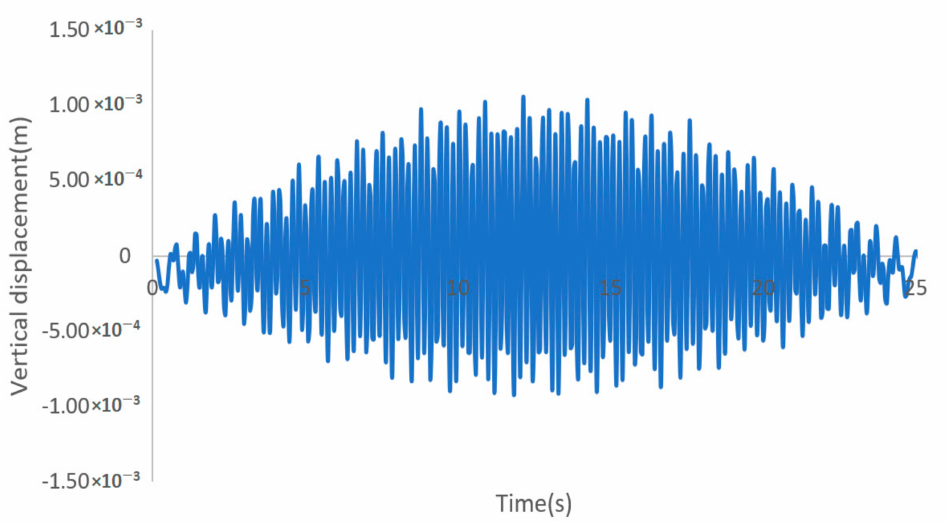
Figure 3. Vertical acceleration history of the